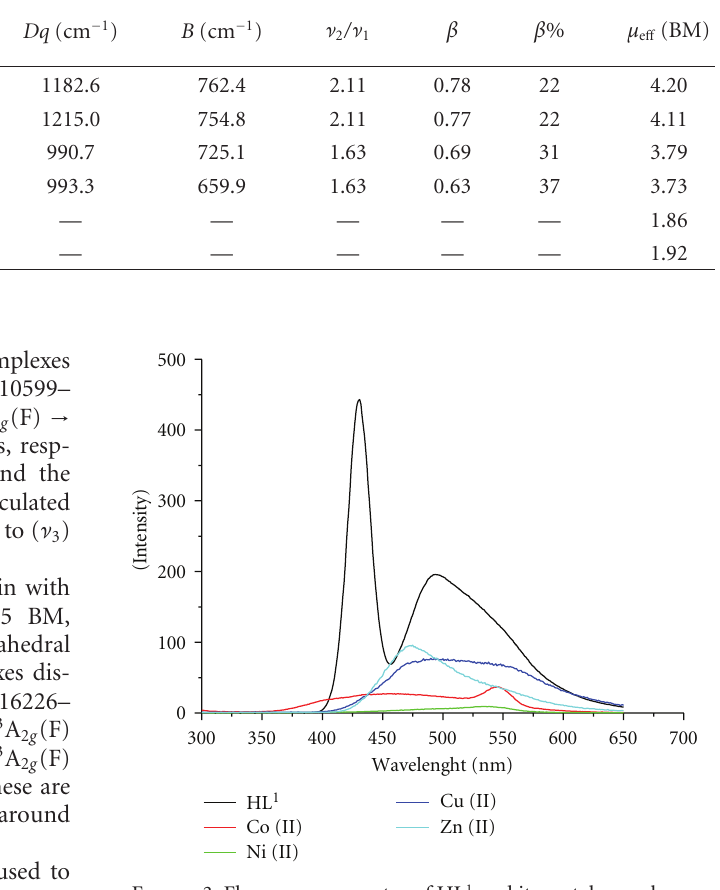
Figure 3: Fluorescence spectra of HL 1 and its metal